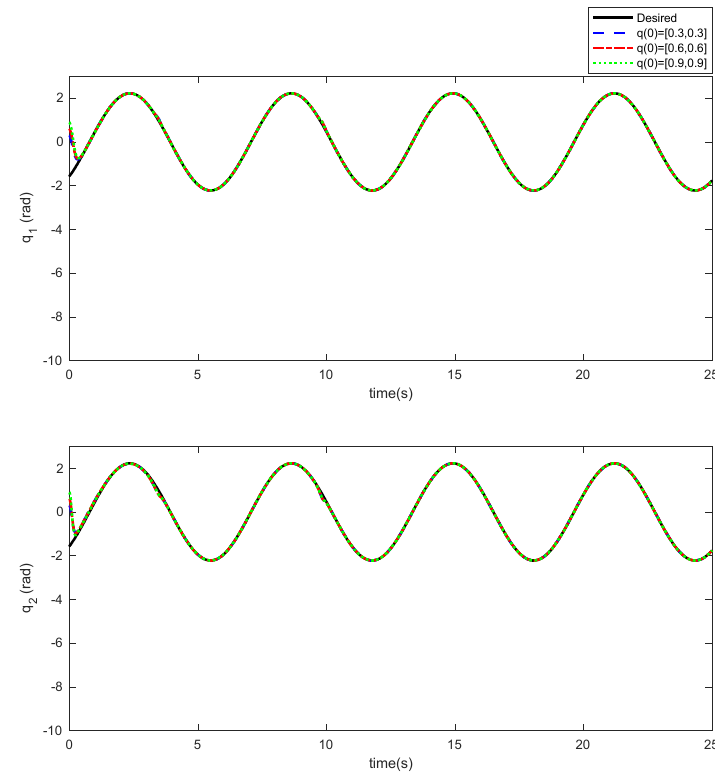
Figure 8. Desired tracking based on Scenario 2.